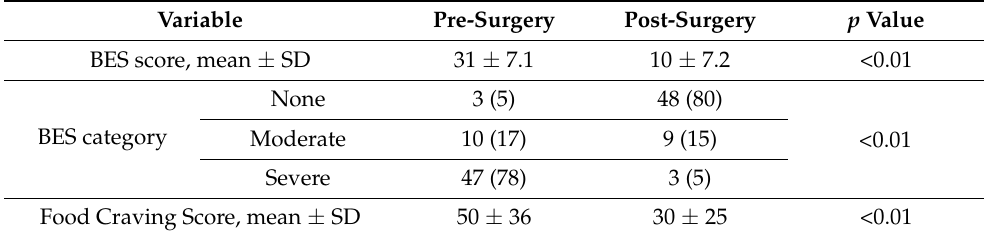
Table 4. Binge Eating Scale score and Food Craving Index score pre- and